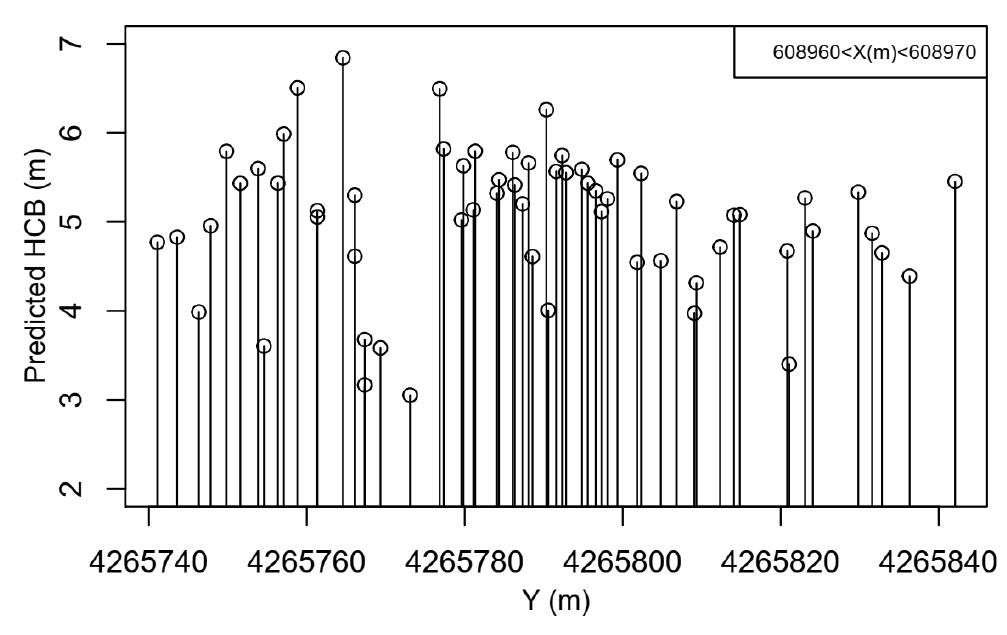
Figure 3. Correlations between LiDAR-derived HCB and ground-measured HCB ( a ), correlation between LiDAR-derived tree height and ground-measured tree height ( b ), correlation between LiDAR-derived crown with and ground-measured crown width ( c ), and correlation between LiDAR-derived crown area and ground measured crown area ( d ). Table 1. Descriptive statistics of tree measurements (SD, standard deviation).